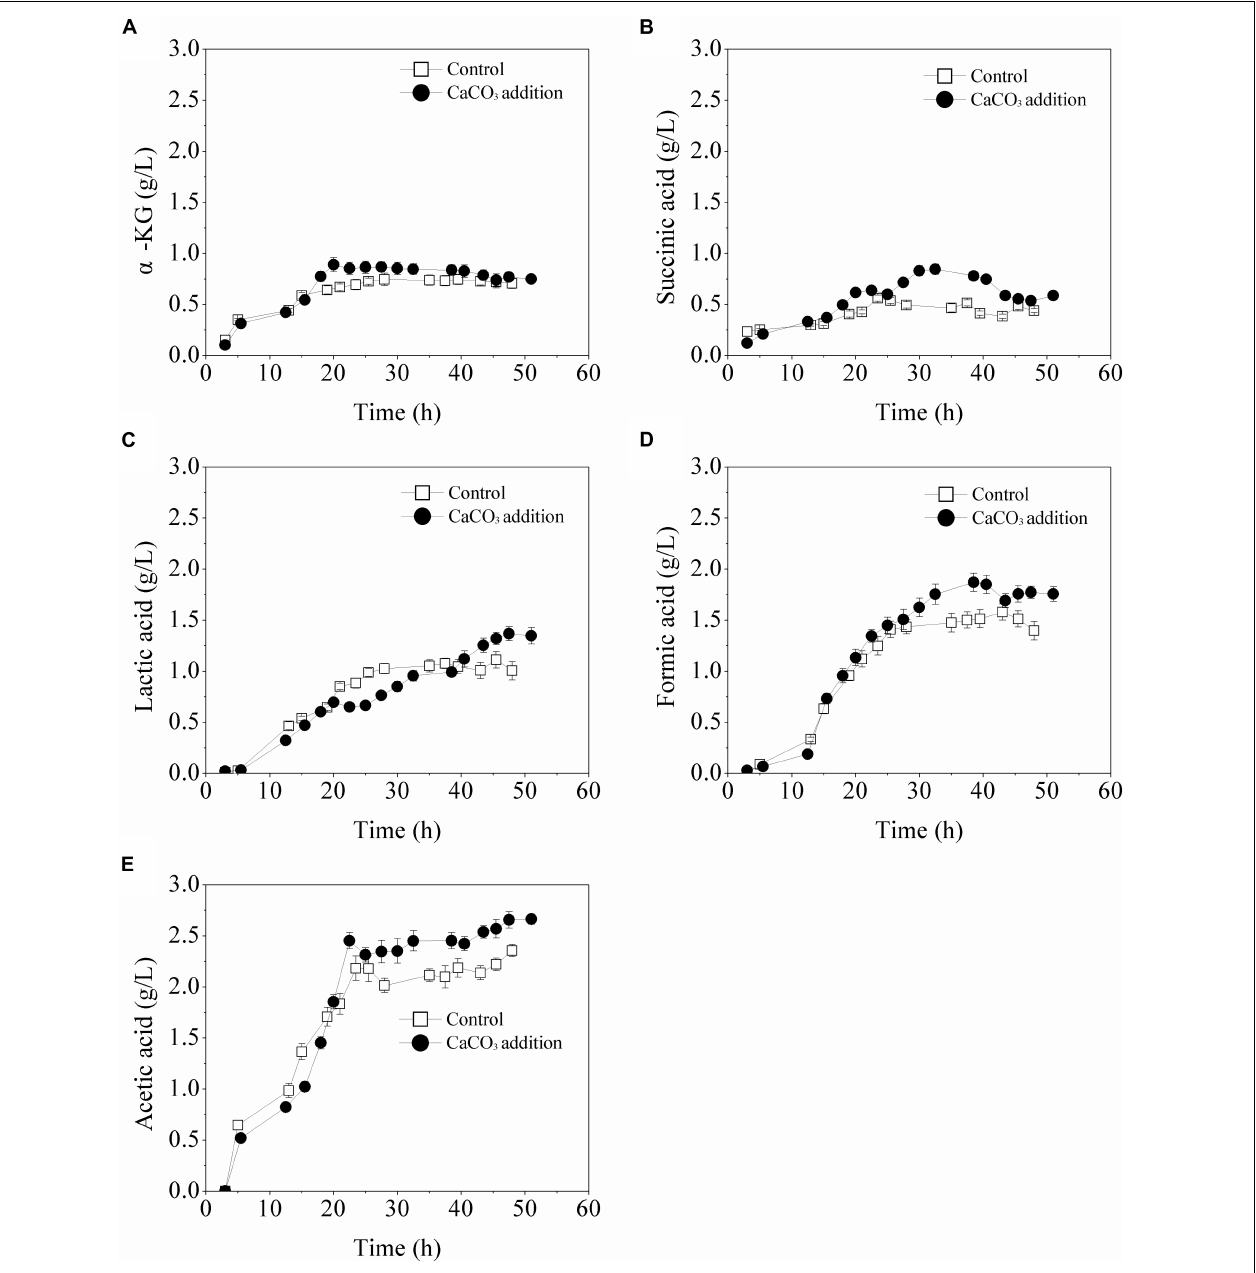
FIGURE 5 | Biosynthesis of organic acids in batch cultures in 5-L fermentor without or with CaCO 3 (30 g/L) addition. SD is shown for triplicate measurements of each organic acid. (A) α -KG, (B) succinic acid, (C) lactic acid, (D) formic acid, and (E) acetic acid.